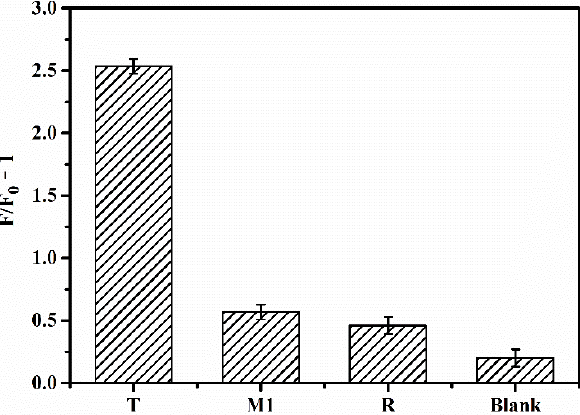
Figure 4. Selectivity of the biosensor. M1, single-base mismatch miRNA; R, noncomplementary random miRNA; T, target miRNA let-7a.